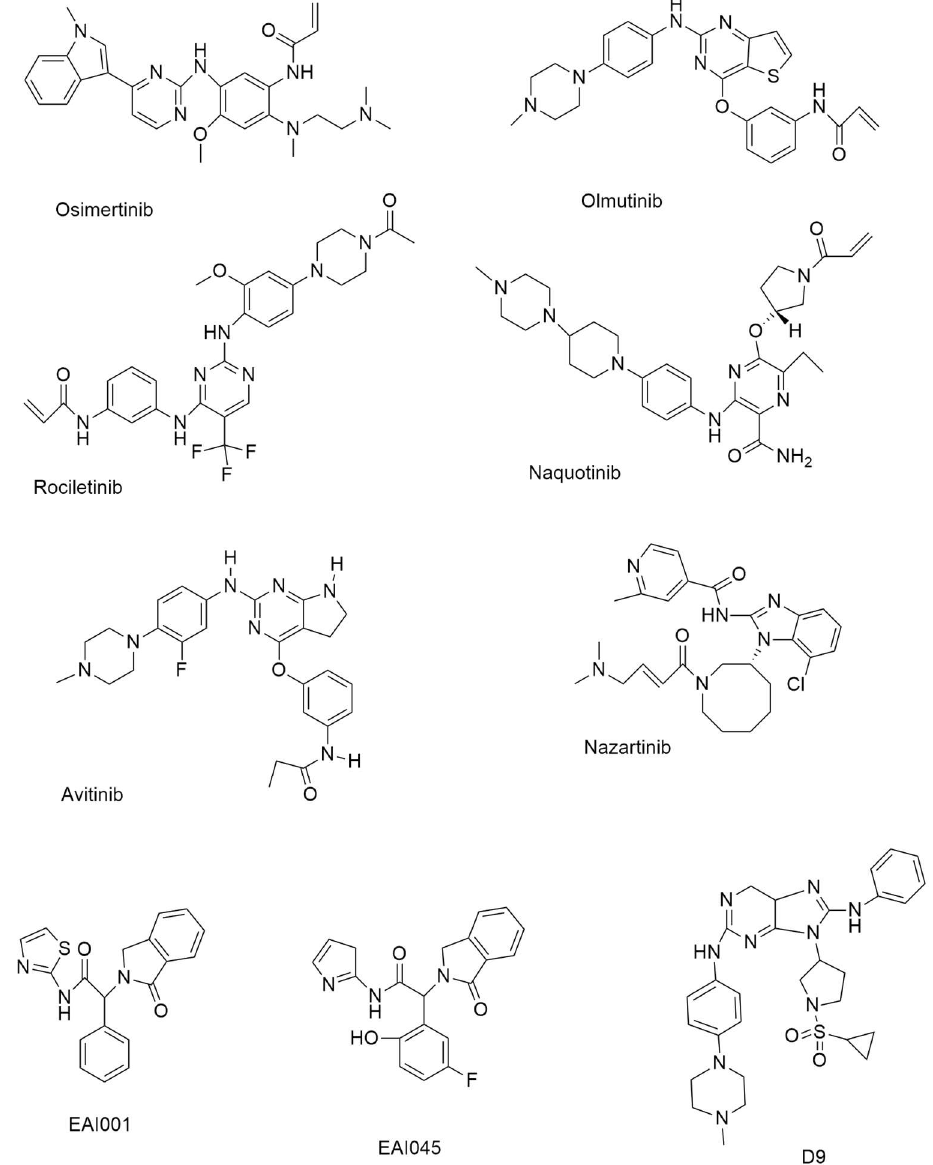
Figure 2. Third-generation and Fourth-generation small molecule